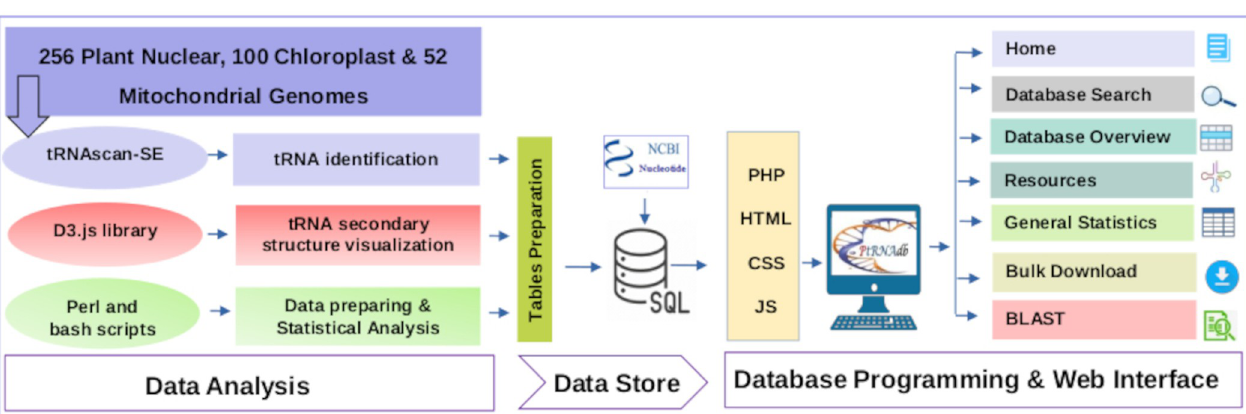
Fig 1. The workflow used in the identification of tRNA genes and the construction of the PltRNAdb database.